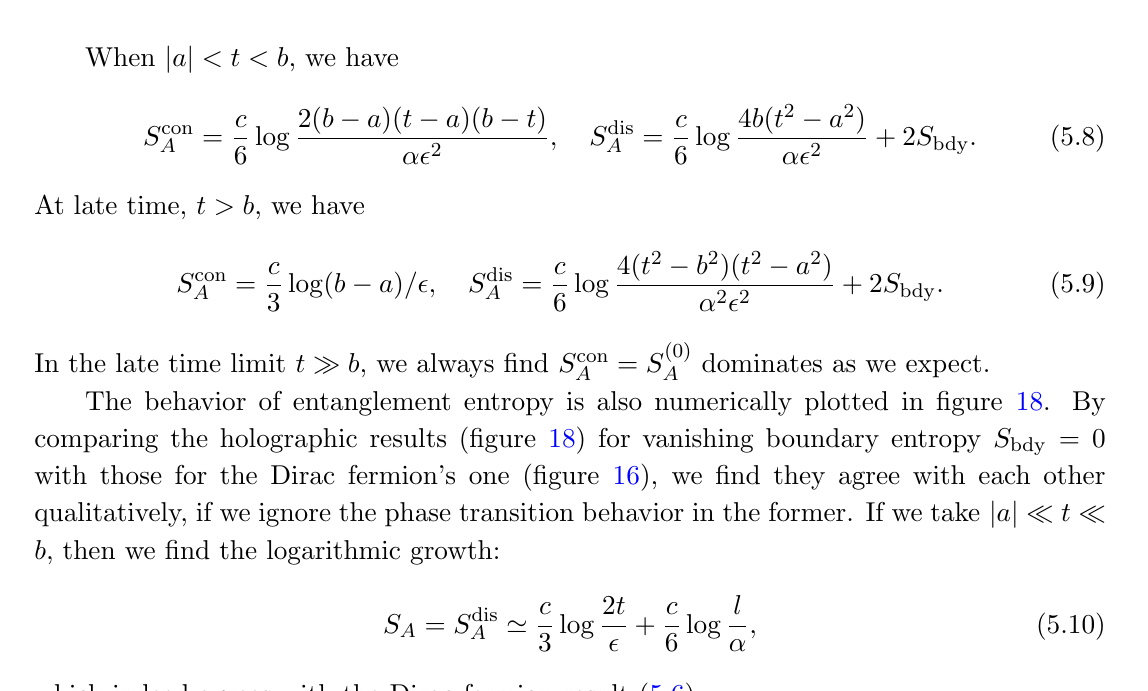
Figure 17 . The plots of the entanglement density (cid:1) n ( (cid:24); l; t ) for (cid:11) = 0 : 1 at t = 0 (left) and t = 1 (right). The horizontal and depth coordinate corresponds to (cid:24) and l ,